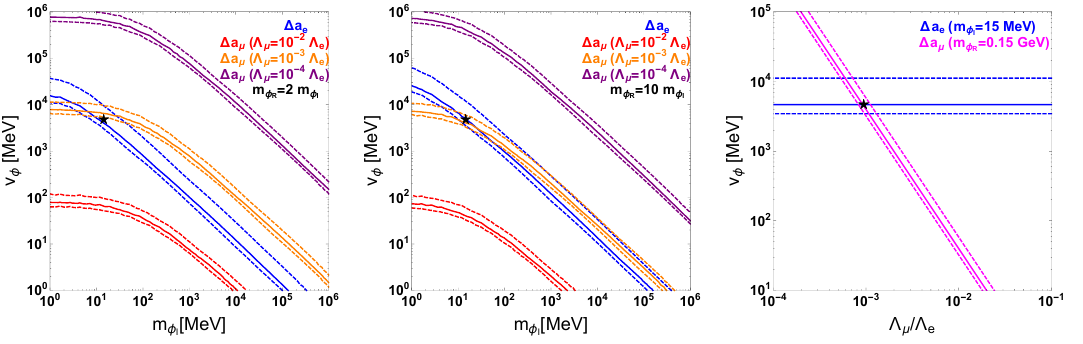
, m (cid:30) , and (cid:3) (cid:22) for (cid:1) a I R